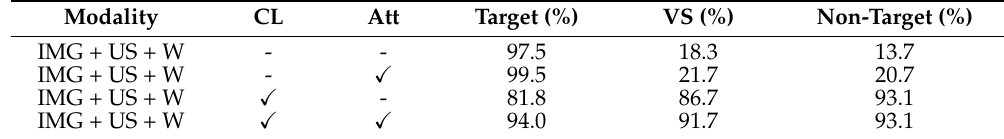
Table 5. Classification results using correspondence learning and multi-modal attention in a real- world database. CL denotes correspondence learning and Att denotes multi-modal